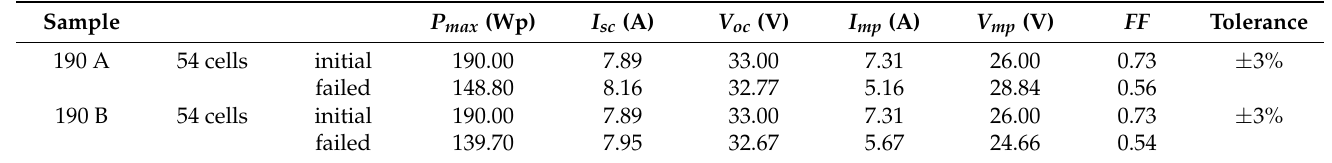
Table 2. Electrical data of the modules in the initial stage and after